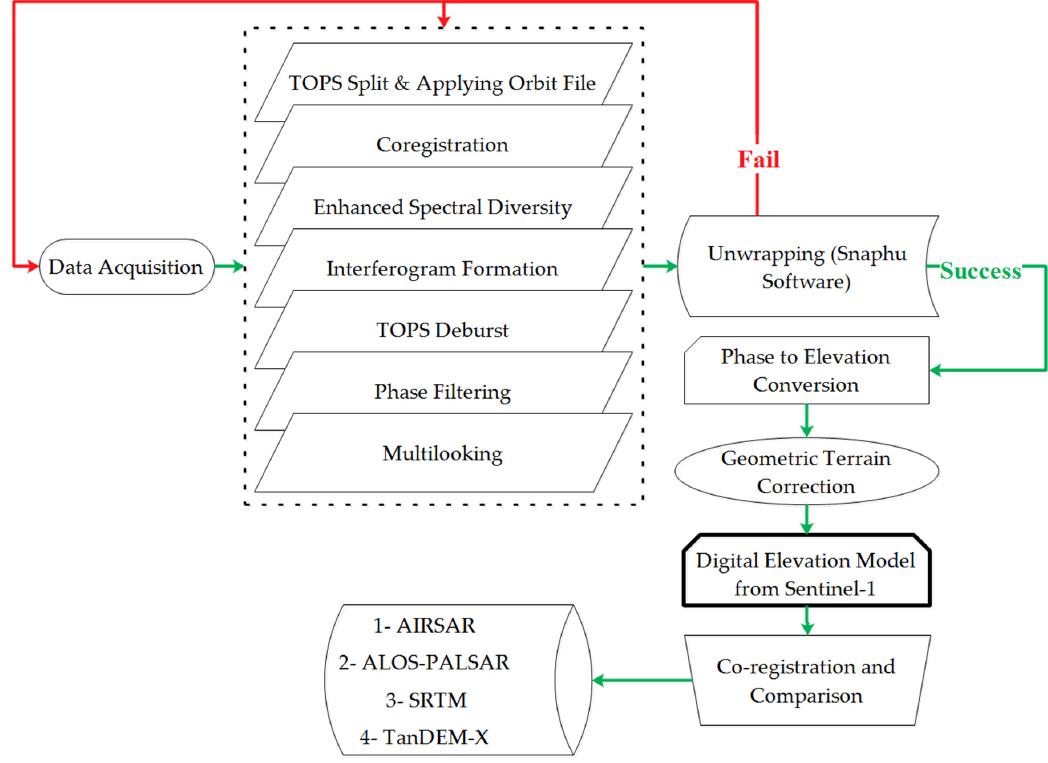
Figure 2. An overview of the proposed methodology.